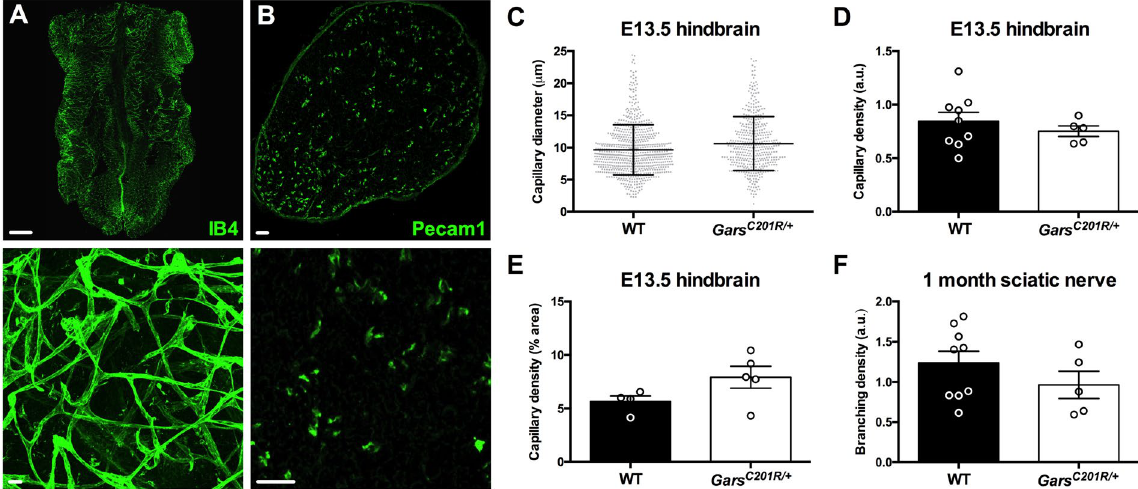
Figure 6. Gars mutant embryonic hindbrains and sciatic nerves show no vascular defects. ( A,B ) Representative single plane ( A , top and B ) and collapsed Z-stack ( A , bottom) images of IB4 and Pecam1 staining (green) in E13.5 hindbrain ( A ) and one month sciatic nerve ( B ), respectively. Scale bars = 1 mm ( A , top) and 20 μ m ( A , bottom, and B ). ( C–E ) Capillary diameter ( C , P = 0.593), density ( D , P = 0.456), and branching density ( E , P = 0.278) are all unimpaired in Gars C201R / + E13.5 hindbrains. n = 9 wild-type and 5 Gars C201R / + . ( F ) Mutant sciatic nerves show no difference in capillary density at one month ( P = 0.111). n = 4 wild-type and 5 Gars C201R / + . All data were analysed with unpaired, two-tailed t -tests. See also Fig.